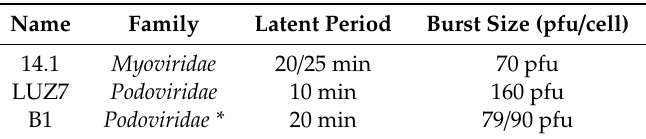
Table 6. General features of